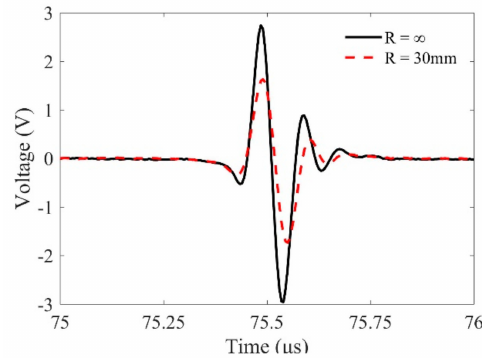
Figure 7. Reference signals reflected from planar and curved front surfaces for calibrating the system